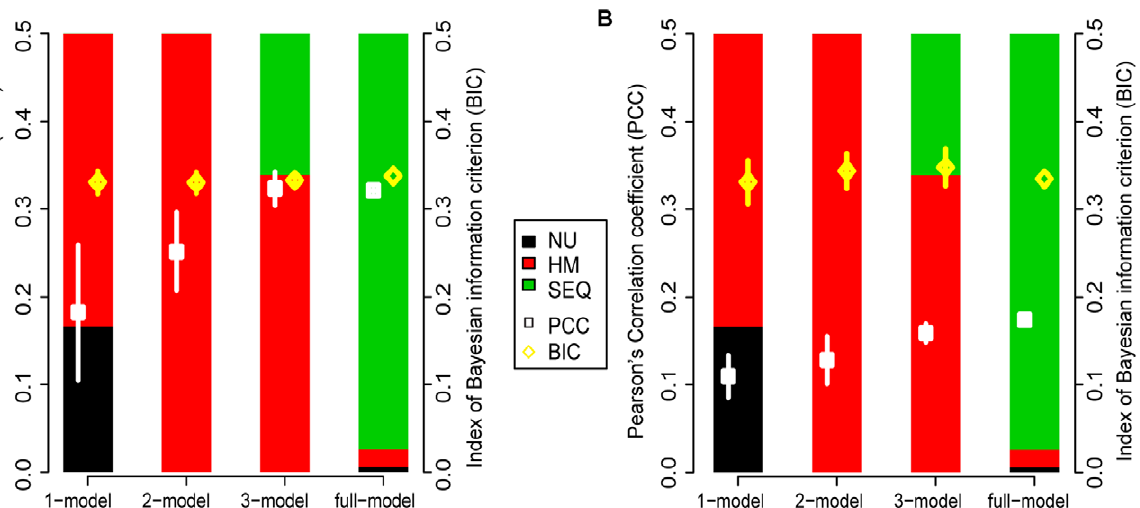
Figure 1. Features selected for the best models in HepG2. Stacked bars represent the distributions of selected feature types between nucleosome position (NU), histone modification levels (HM), and DNA sequence information (SEQ). The bar length represents the selected fraction of each type of features (with the range from 0 to 1). Squares and diamonds represent the mean PCC and the mean BIC of the best models in the corresponding model categories, respectively, A) for CpG-related promoters, and B) for nonCpG-related promoters.